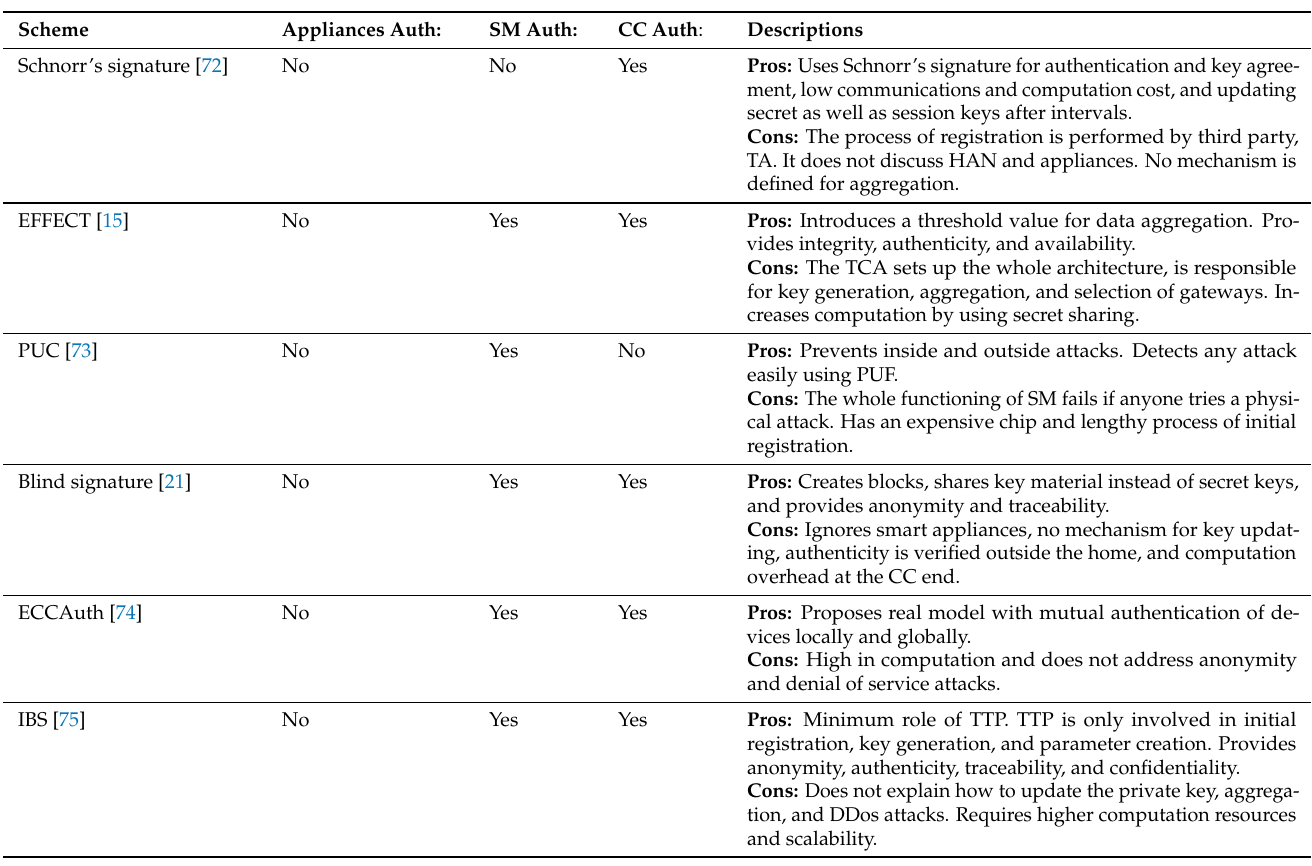
Table 3. Summary of authentication